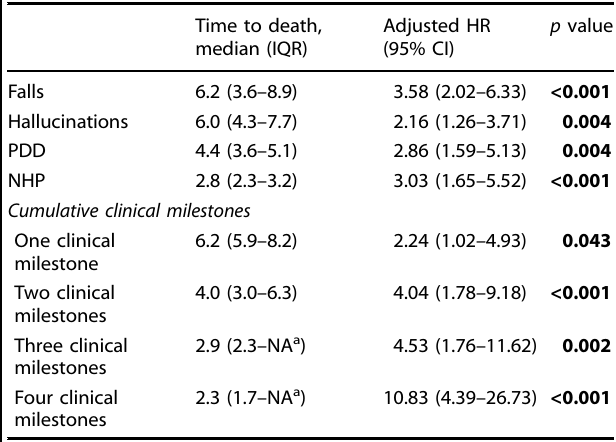
Table 1. Baseline characteristics of Parkinson ’ s disease patients and normal controls.